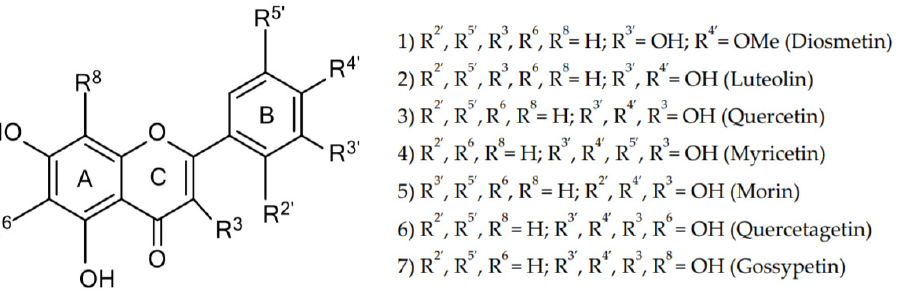
Figure 1. Chemical structures of the studied flavonoids.